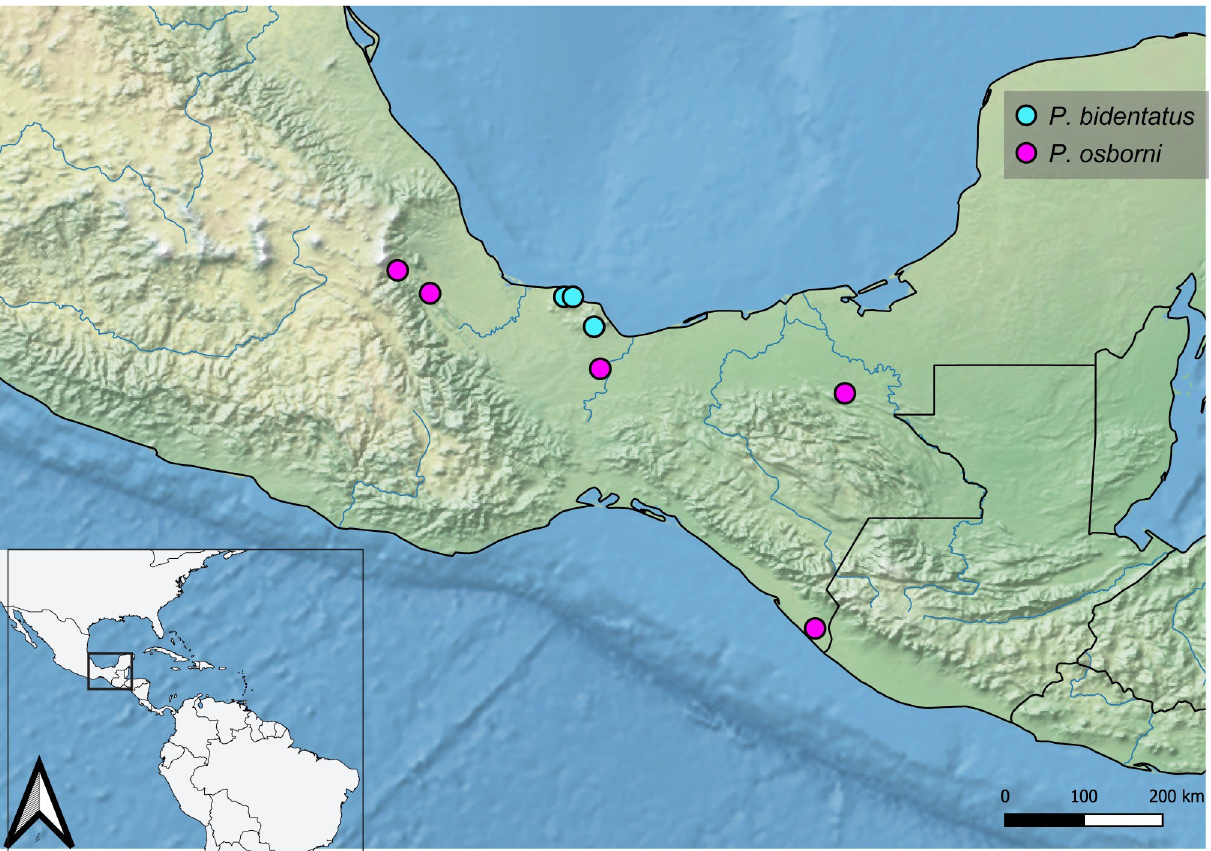
Fig 37. Map showing the geographical distribution of species of P . bidentatus , P . osborni . Spatial data from Natural Earth (http://www. naturalearthdata.com/). laterotergites black, lateral margins of mediotergites with longitudinal stripe of golden setae; side of abdomen black; sterna without marks. Male : abdominal sterna without depressions; posterior margin of abdominal mediotergite VII rounded (Fig 7A). Posterior projection of last abdominal laterotergite (= connexival spine) with apex rounded (Fig 7A). Abdominal sternum VII with oval notch on posterior margin, notch almost three times as wide as long. Abdominal segment VIII tubular, 2–3 times as long as wide, without ventral depression; lateral margins slightly tapering posteriorly, unmodified; anterior width 2–3 times posterior width; postero- dorsal margin rounded; posteroventral margin with lateral triangular projection (Fig 7B, 7E and 7F). Pygophore and proctiger sinistrally rotated about 30˚ (Fig 7A, 7B, 7E and 7F). Pygo- phore 2.1–2.4 times longer than abdominal segment VII. Proctiger 1.8–2.0 times longer than abdominal segment VII; anterior margin with short notch, notch with about 1/5 of length of proctiger; right margin not folded ventrally; left margin folded only on left basolateral process; apex with many black denticles; right basolateral process not developed; left basolateral process with length 4/5 to subequal to its width, with 1/5 of length of proctiger, longitudinal axis diverging about 45˚ from longitudinal axis of proctiger, lateral margins converging to apex, apex not bifid (Fig 7J). Phallus length about 1/3 of smallest width (Fig 7G); dorsal sclerite slightly longer and narrower than ventral sclerite, base not notched (Fig 7H); lateral sclerite rectangular; ventral sclerite centrally notched, base bifid, apex almost twice as wide as center